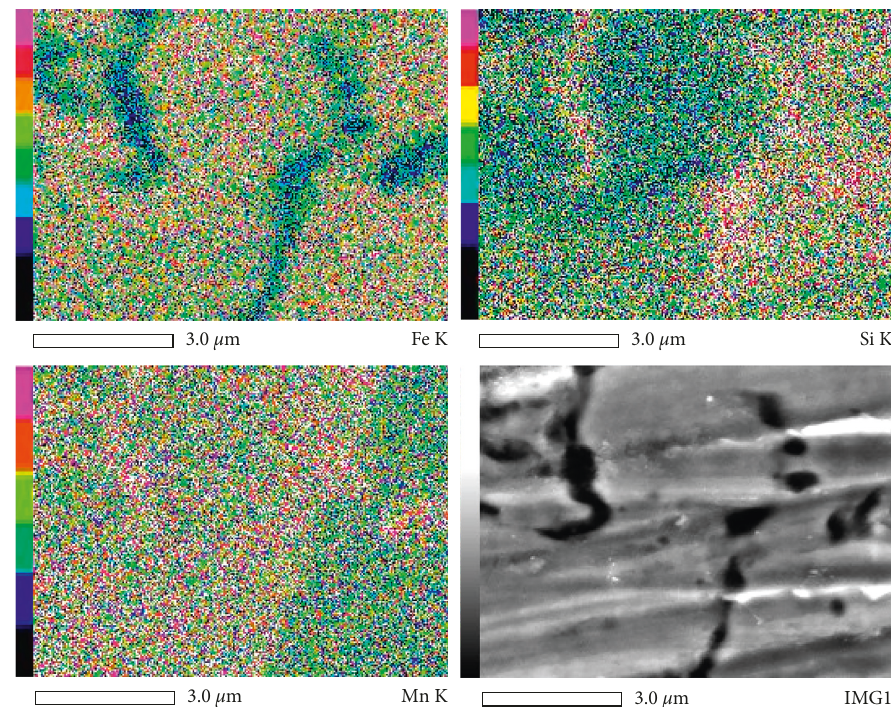
Figure 2: SEM and EDX analysis of Fe-30Mn-6Si bulk alloy after sintering without preceding MA